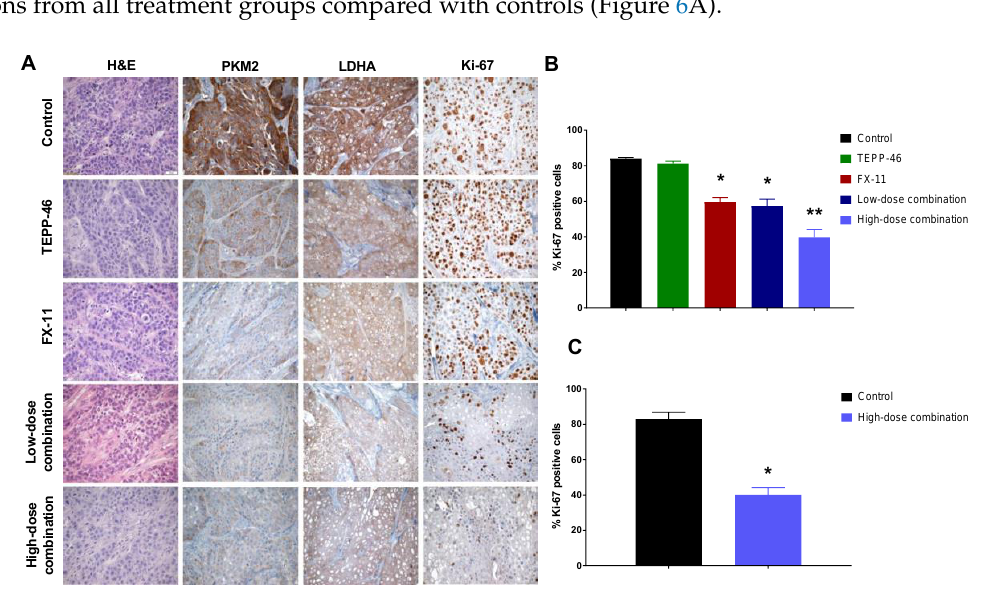
Figure 5. Glycolytic enzyme activity in plasma and tumor lysates in response to TEPP-46, FX-11, and combination therapy in the subcutaneous BxPc-3-Luc tumor model. ( A ) PK activity and ( B ) LDHA activity. Overall, TEPP-46 treatment increased PK activity and FX-11 treatment decreased LDHA activity in plasma and tumor lysates. Enzyme activity in plasma was reflected by enzyme activity in tumor lysates. Data presented as mean ± SE. * indicates significantly different from controls ( p < 0.05, 1-way ANOVA).